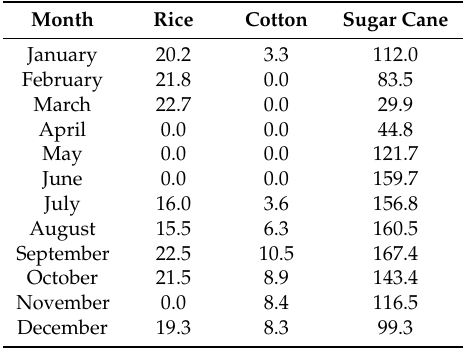
Table 2. Proportionate monthly demands for crops in Tana Basin (adapted from [40]).